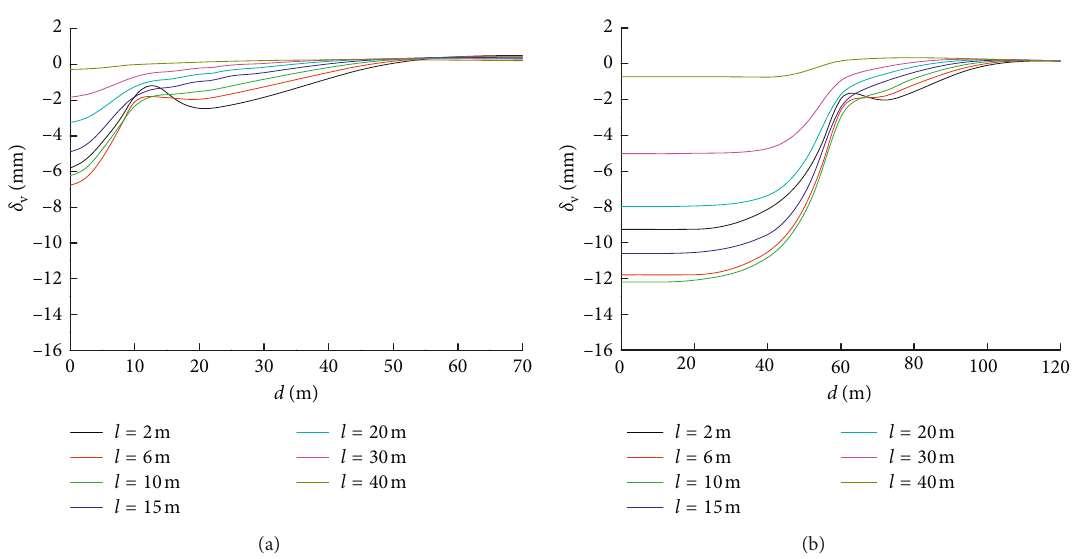
Figure 5: Ground surface settlements in the parallel auxiliary planes outside the (a) short side and (b) long